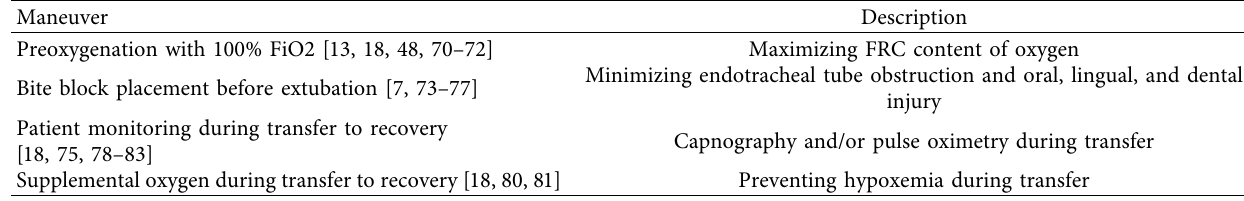
Table 3: Adjunct maneuvers to maintaining successful